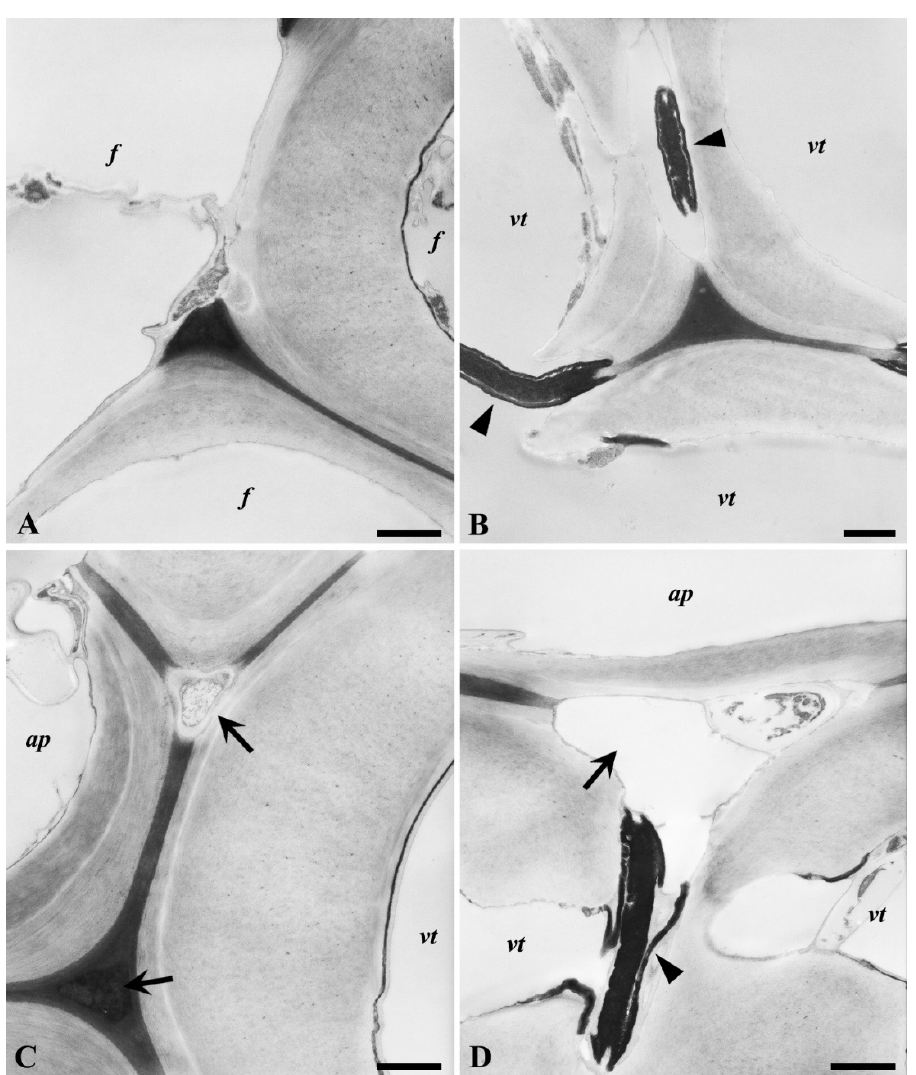
Figure 11. TEM observations of oak wood decayed by T. versicolor . Thinning of the secondary cell wall of a (libriform) fiber ( f , A ), (vasicentric) tracheid ( vt , B – D ), and apical parenchyma cell ( ap , D ) from the lumen outwards. Note degradation of the middle lamella and the secondary cell wall through intercellular spaces and electron-lucent regions between tracheids associated with apical parenchyma cells (arrows in C , D ). Pit membranes between tracheids showed high decay resistance and strong electron density (arrowheads in B , D ). Scale bars: 1 µm.